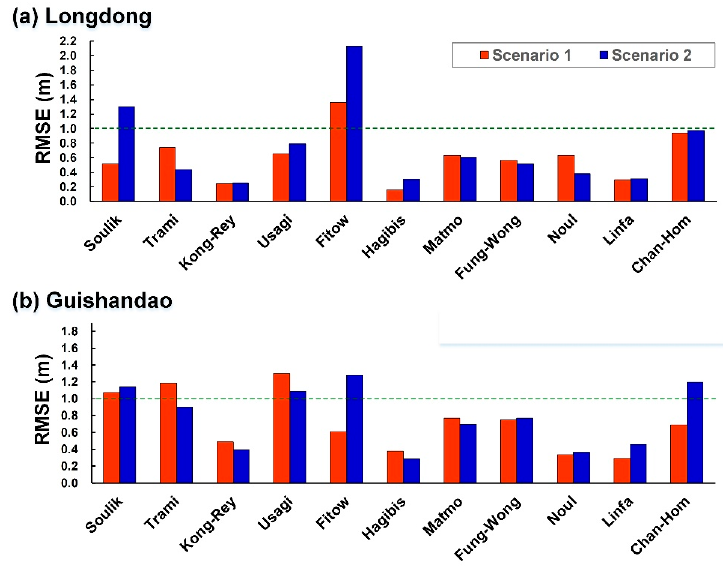
Figure 10. The RMSE of each typhoon in the testing set: ( a ) Longdong buoy and ( b ) Guishandao